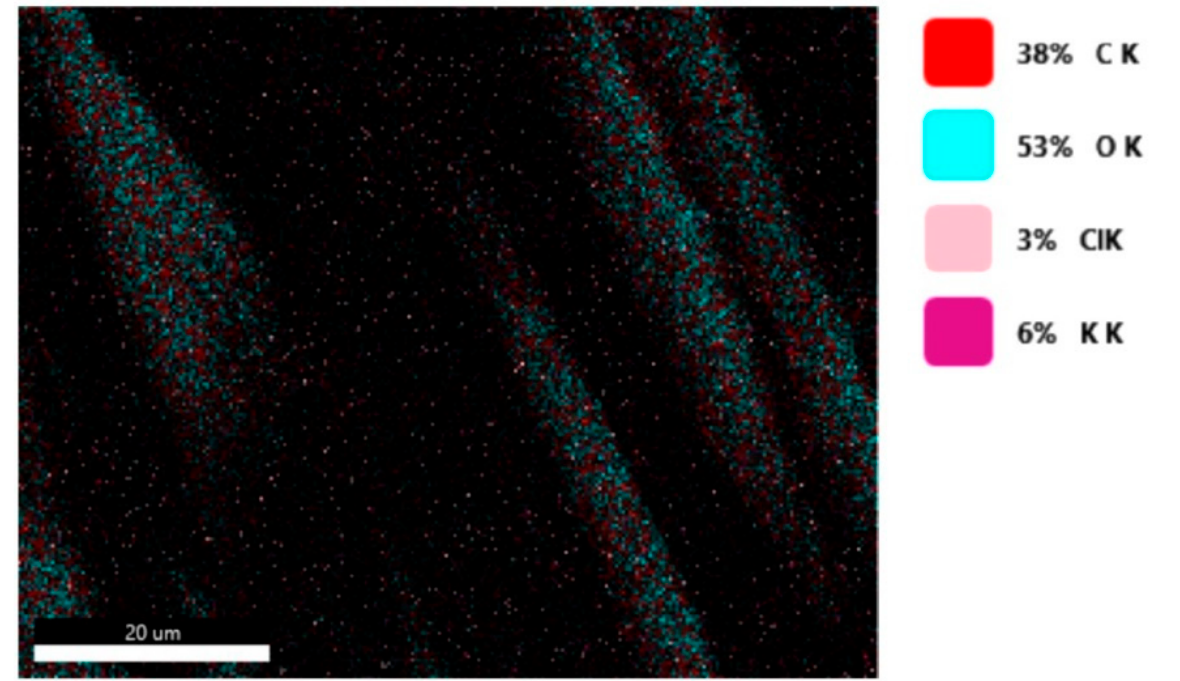
Materials 2021 , 14 , x FOR PEER REVIEW